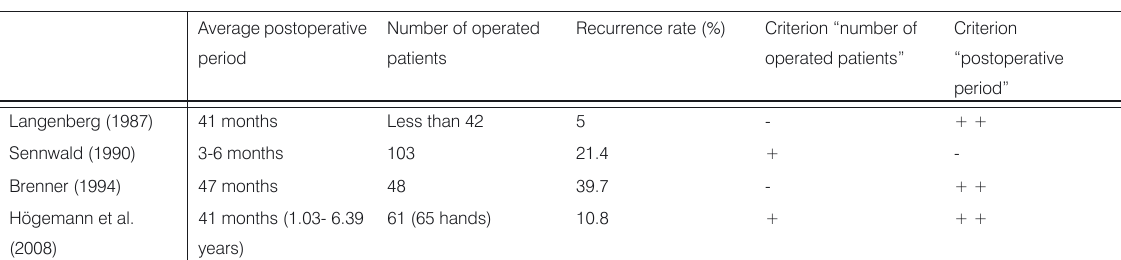
Table 6. Results after total